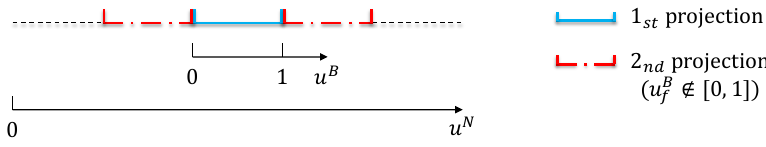
Figure 12. Illustration of the second projection onto an adjacent Bézier curve segment if the first projection yields an out-of-span